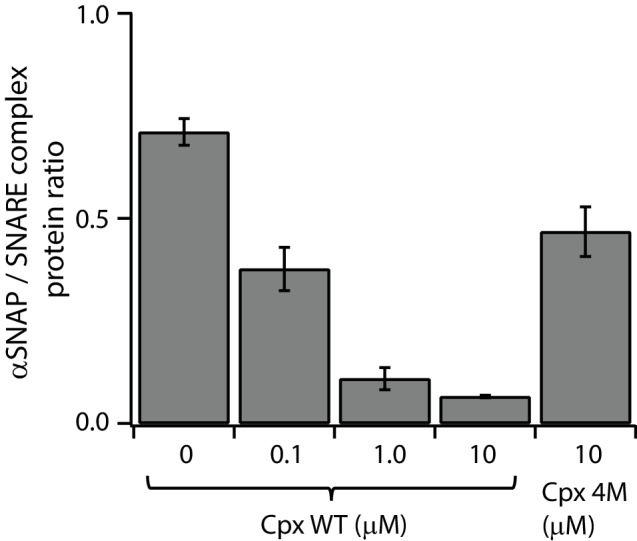
Competition of αSNAP and Cpx binding to the L-SNARE complex.A single-molecule competition experiment. Alexa 647 labeled L-SNARE complex was surface-tethered through biotin-streptavidin linkage on a PEG coated surface of the microscope slide. Alexa 555-labeled αSNAP was concurrently mixed with 0.1 µM, 1.0 µM, and 10 µM Cpx (corresponding to a 1:10, 1:100, and 1:1000 molar ratio of αSNAP:Cpx, respectively) and incubated for 5 min to the surface-tethered L-SNARE complex. The Cpx 4M mutant that blocks the binding to the SNARE complex was used as control. Proteins that did not bind to the surface-tethered L-SNARE complex were washed away before smFRET efficiency measurements. Shown are mean values ± SD for the number of Alexa 555-labeled αSNAP divided by the number of Alexa 647 labeled L-SNARE complexes observed in three fields of view.